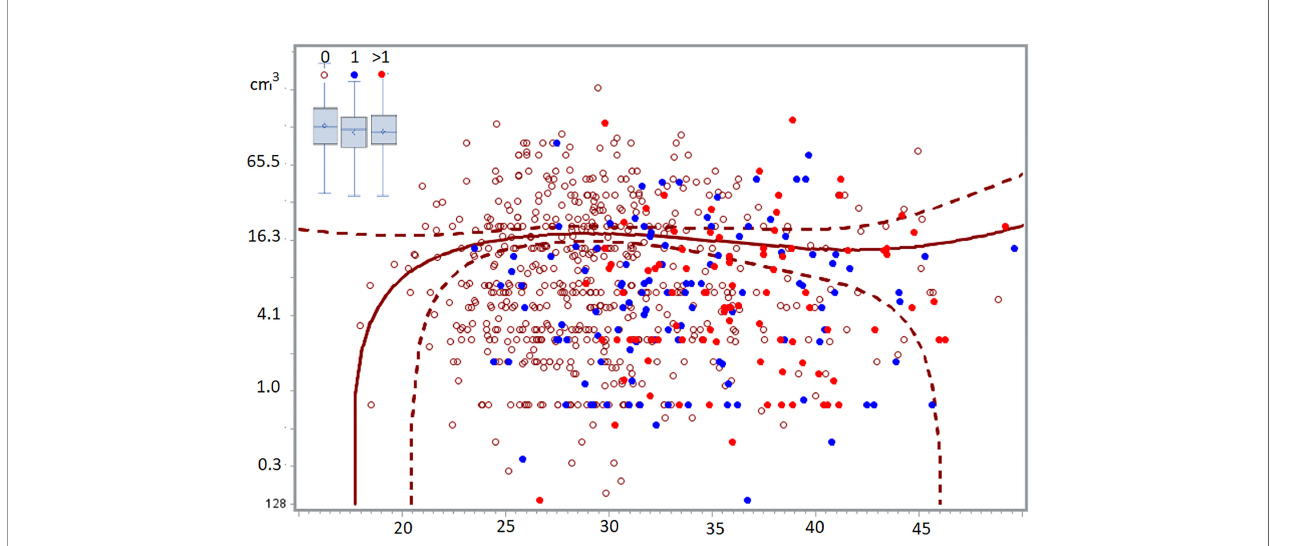
FIGURE 2 | The volume of deep endometriosis lesions (cm 3 ) does not vary between 24 and 50 years, for women without, with one or more than 1 child. The least- square regression analysis with 95% con fi dence limits indicate women without children. In the insert, the boxplots of women with 0, 1 or >1 children demonstrated the absence of a difference between the 3 groups